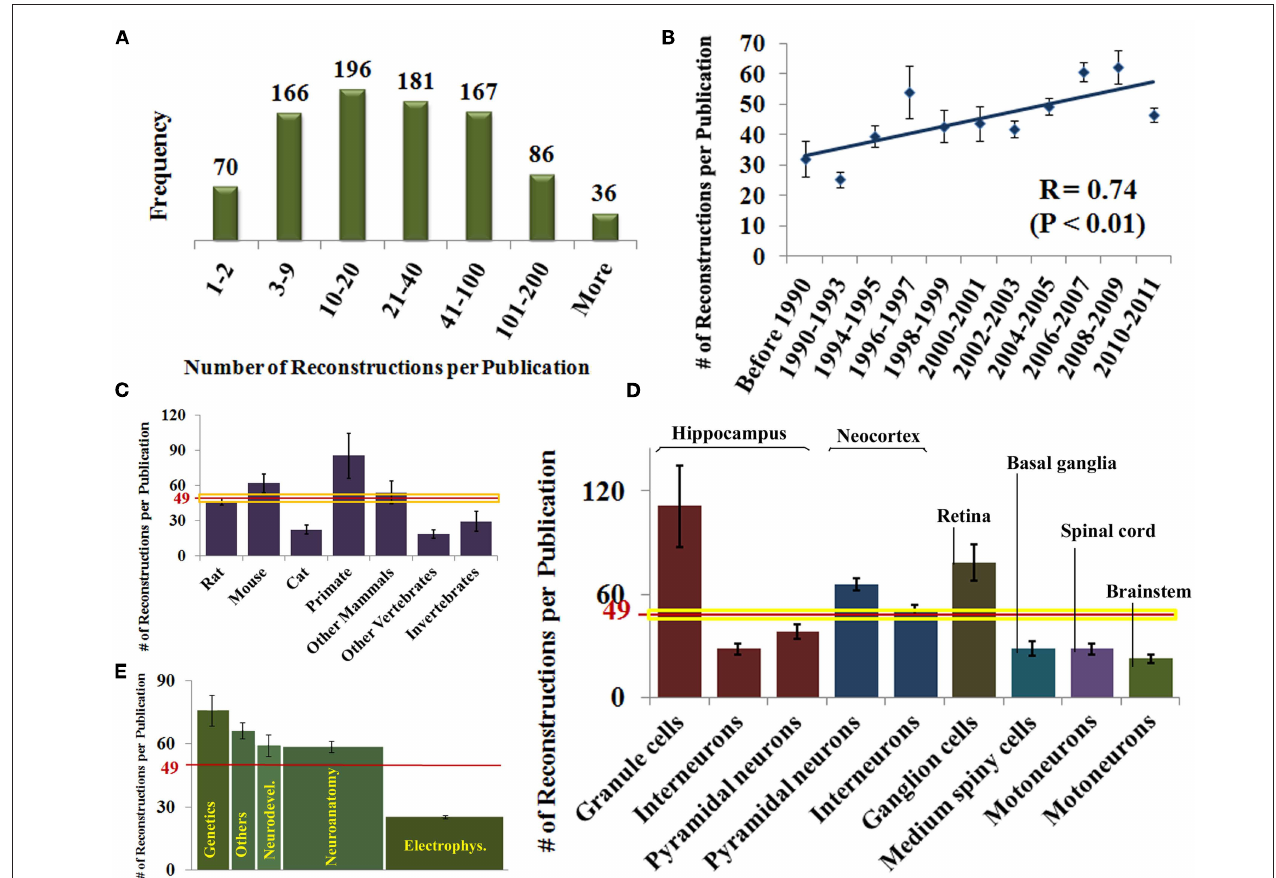
Figure 3 | (A) Histogram distribution of the number of reported reconstructions per publication. (B) Rising temporal trend of the number of reconstructions per publication (mean ± SEM). (C) Number of reconstructions per publication by species. The horizontal red and yellow lines represent mean